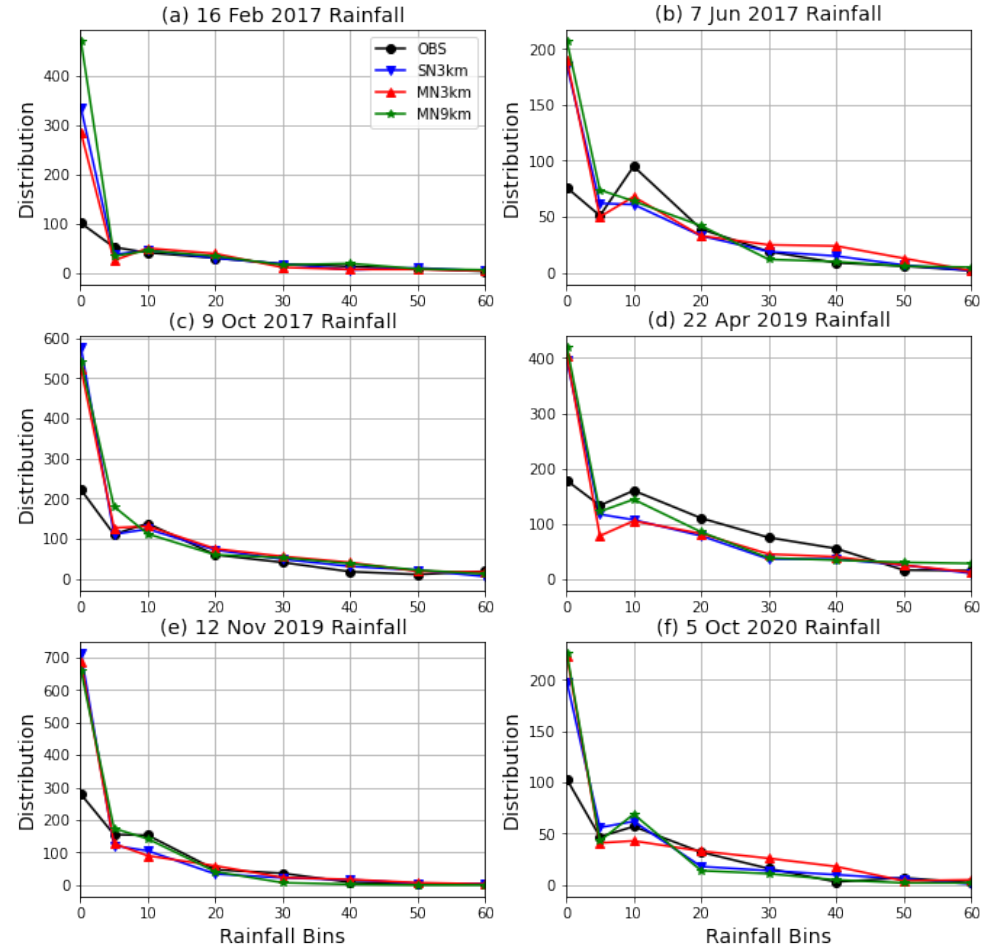
Figure 9. The number of stations at which rainfall is simulated in the 0.1 to 5 mm, 5 to 10 mm, and 10 to 60 mm ranges with intervals of 10 mm for all six events in the following order: ( a ) tropical cyclone Dineo, ( b ) the Cape storm, ( c ) the KZN 2017 October floods, ( d ) the KZN 2019 April floods, ( e ) the KZN 2019 tornadoes and ( f ) the Johannesburg